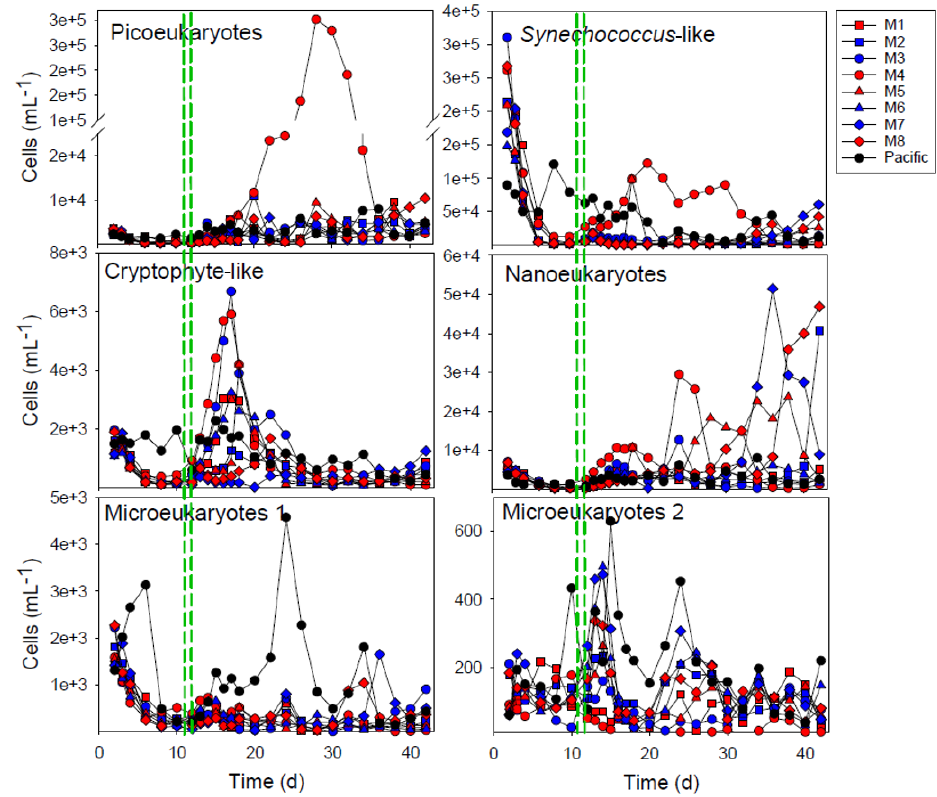
Figure 4. Development of the main groups of phytoplankton enumerated by flow cytometry. The red and blue colors denote the mesocosm bags with the addition of water with a low (closer to shore) and very low (further offshore) oxygen minimum zone (OMZ) signature, respectively. The green dashed lines denote the time of OMZ-water addition. Pacific denotes measurements from water collected next to, but outside of, the